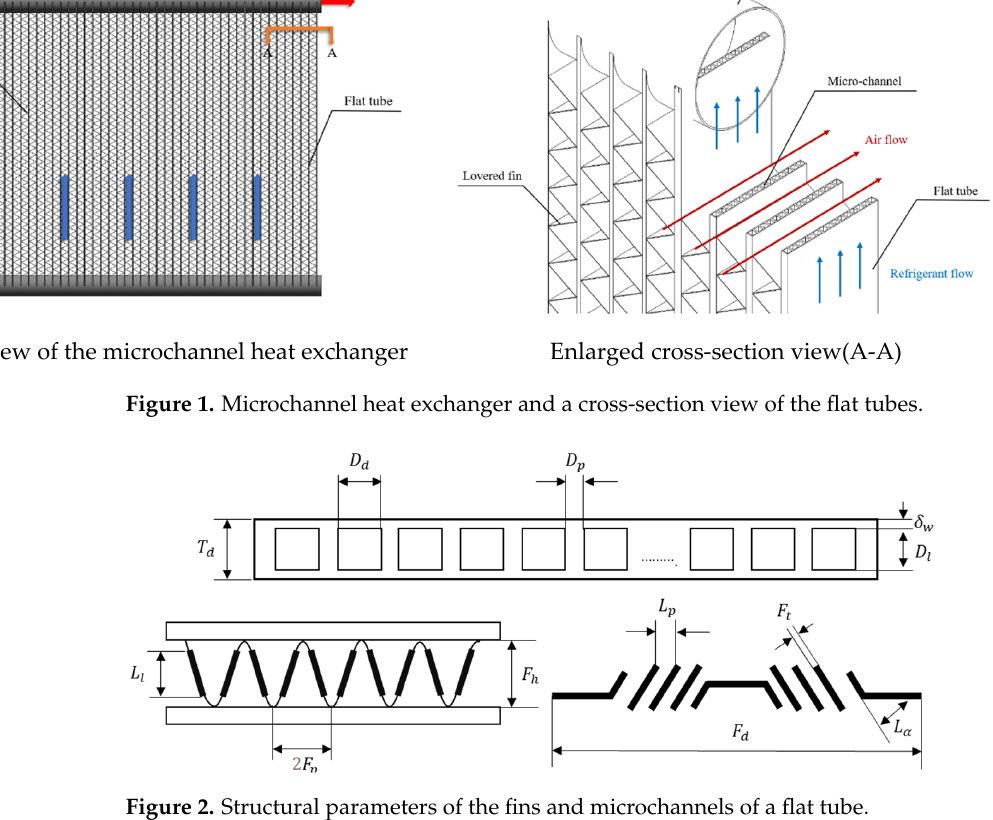
Figure 2. Structural parameters of the fins and microchannels of a flat tube.